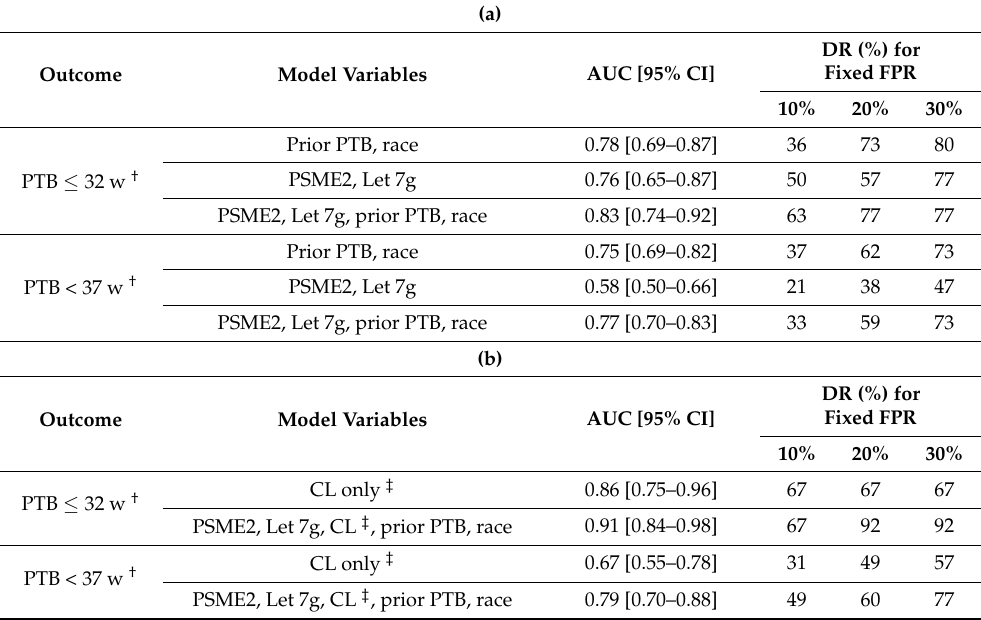
Table 5. (a). Prognostic accuracy for preterm birth (PTB) ≤ 32 weeks and PTB < 37 weeks. (b). Prognostic accuracy for preterm birth (PTB) ≤ 32 weeks and PTB < 37 weeks—CL